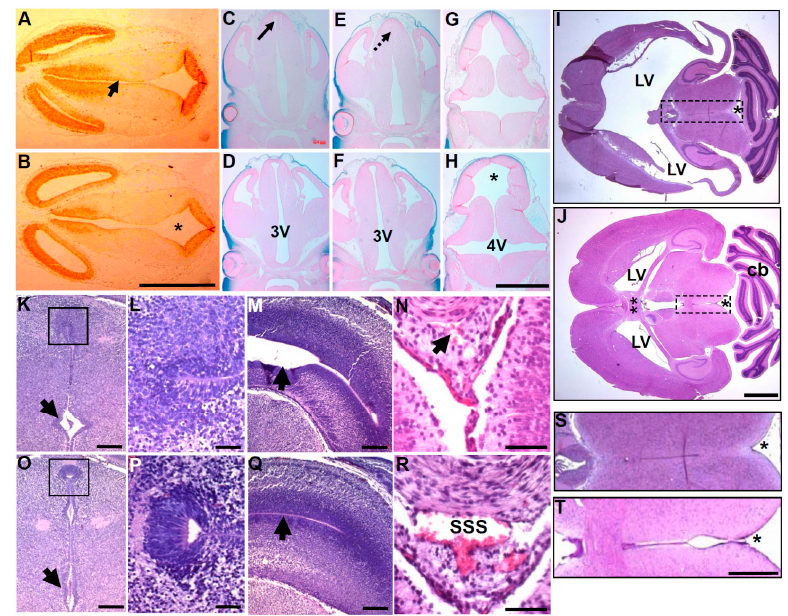
Figure 2. Histological analysis of ventricular dilation and tissue loss in Pax3 flox/flox /Wnt1-Cre mutants. ( A , B ) Histology revealed a narrow third ventricle (arrow) along the E12.5 mutant ( A ) anterior-posterior axis compared to control ( B ); ( C – H ) E13.5 coronal sections from anterior to posterior and stained for lacZ reporter (blue) and eosin (pink) of Pax3 flox/flox /Wnt1-Cre;R26r mutants ( C , E , G ) and Wnt1-Cre/R26r controls ( D , F , H ); Opening of the dorsal part of mutant third ventricle (3v) is narrow (arrow, C ) or contracted (broken arrow, E ) compared with the control ( D , F ). However, at this stage there is a connection between both mutant and control third ventricle and aqueduct (asterisk); ( I , J ) hematoxylin and eosin horizontal sections from P20 mutant ( I ) and control ( J ). Note mutant lateral ventricles (LV) are enlarged and fused due to loss of normal interventricular tissue (double asterisk, J); ( K – R ) hematoxylin and eosin stained transverse sections of E16.5 Pax3 flox/flox /Wnt1-Cre ( K – N ) and control brains ( O – R ); L , P are magnified in areas indicated in K , O and clearly show diminished opening of dorsal part of the mutant third ventricle and an under-developed subcommissural organ ( K , L ); as a consequence of likely impaired fluid flow, the mutant medial region (arrow, K ) is remarkably enlarged compared to control (arrow, O ). Additionally, mutant lateral ventricle (arrow, M ) is significantly dilated. Although the superior sagittal sinus (SSS) is easily recognizable in control ( R ) it is obscure and undersized in the Pax3 flox/flox /Wnt1-Cre mutants (arrow, N ); ( S,T ) enlarged images of boxed areas in I , J illustrate the lack of connection between the mutant third ventricles and aqueducts (asterisks) in mutants ( S ) but not in controls ( T ). Scale bars: A–D,F–I = 1mm; E,J = 2mm; S,T = 0.5mm. 3.3. Wnt1-Cre Lineage Mapping Reveal that Ventricular Neuroepithelium and Subcommissural Organ Morphogenesis Requires Pax3 Wnt1-Cre mediated Cre expression is known to be expressed in both the dorsal neuroepithelium before NC delamination and within migratory NC and their derivatives [7]. Thus, to determine whether the observed stenosis of third ventricle is directly related to previous Wnt1-Cre -mediated Pax3 deletion during early embryonic cranial development, we mapped expression of β -